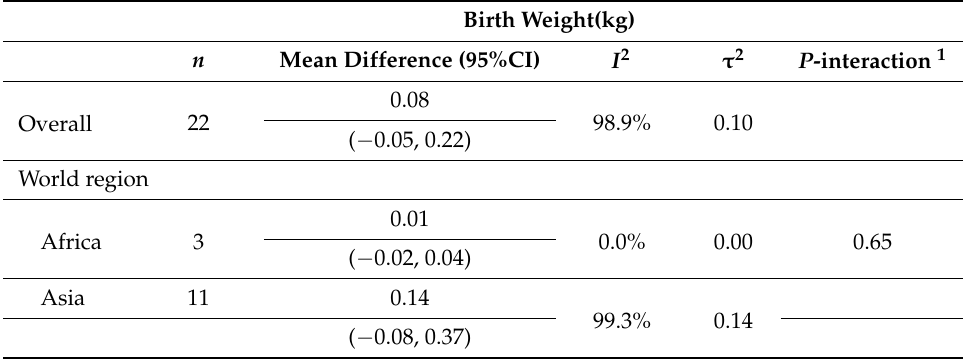
Table 2. Main and subgroup analyses of the effects of zinc supplementation during pregnancy on birth